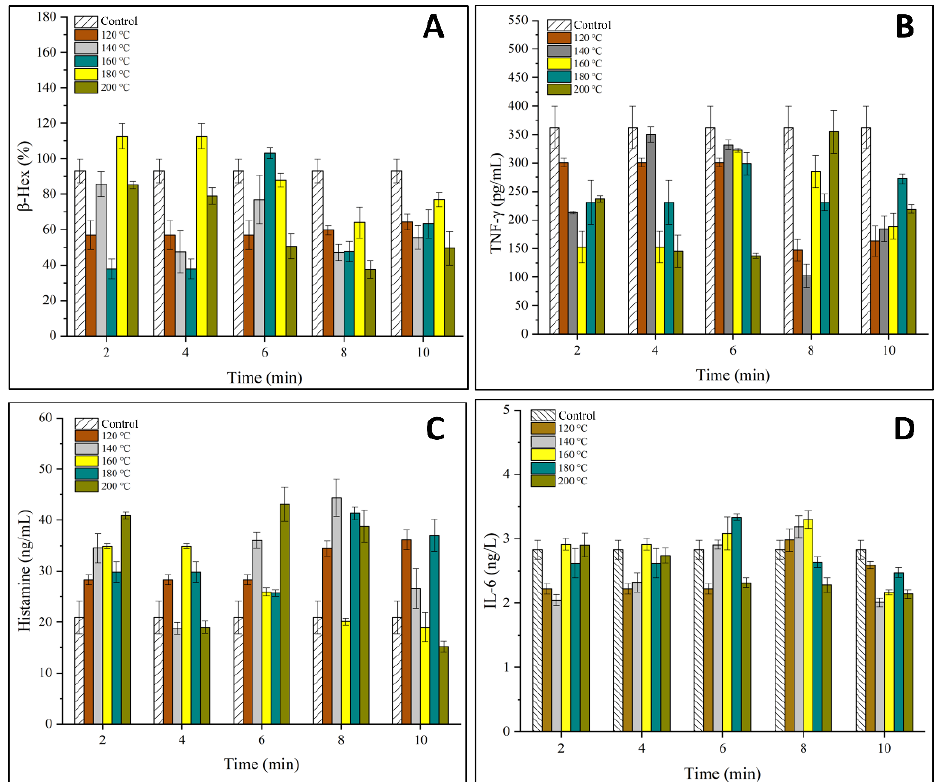
Figure 3. Effects of SS-treated OVM at different temperatures and times on the degranulation of